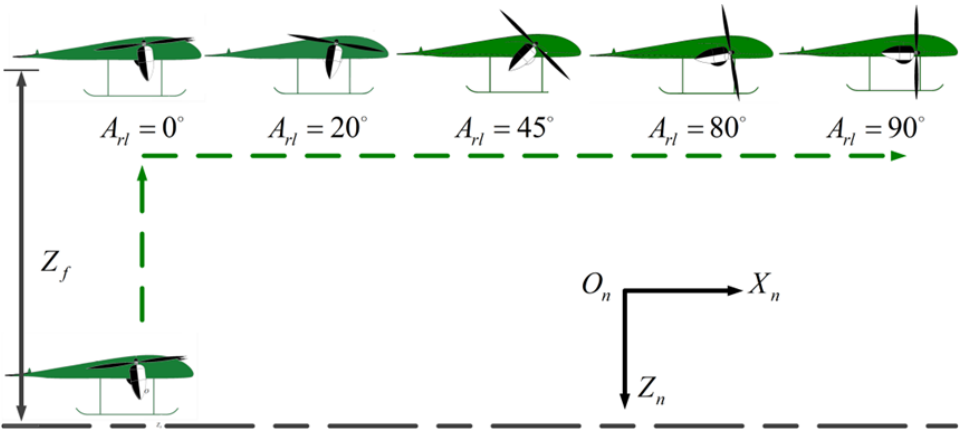
Figure 7. The flight path of VTO